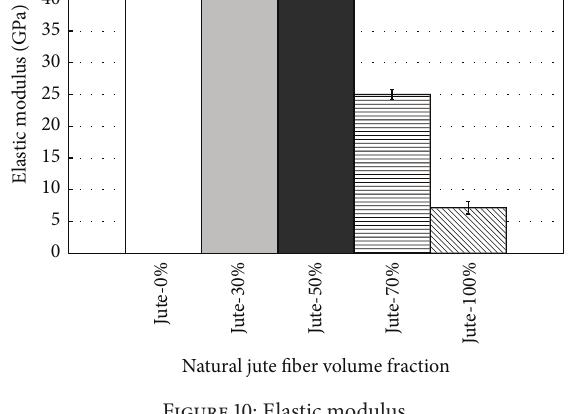
Figure 10: Elastic modulus.